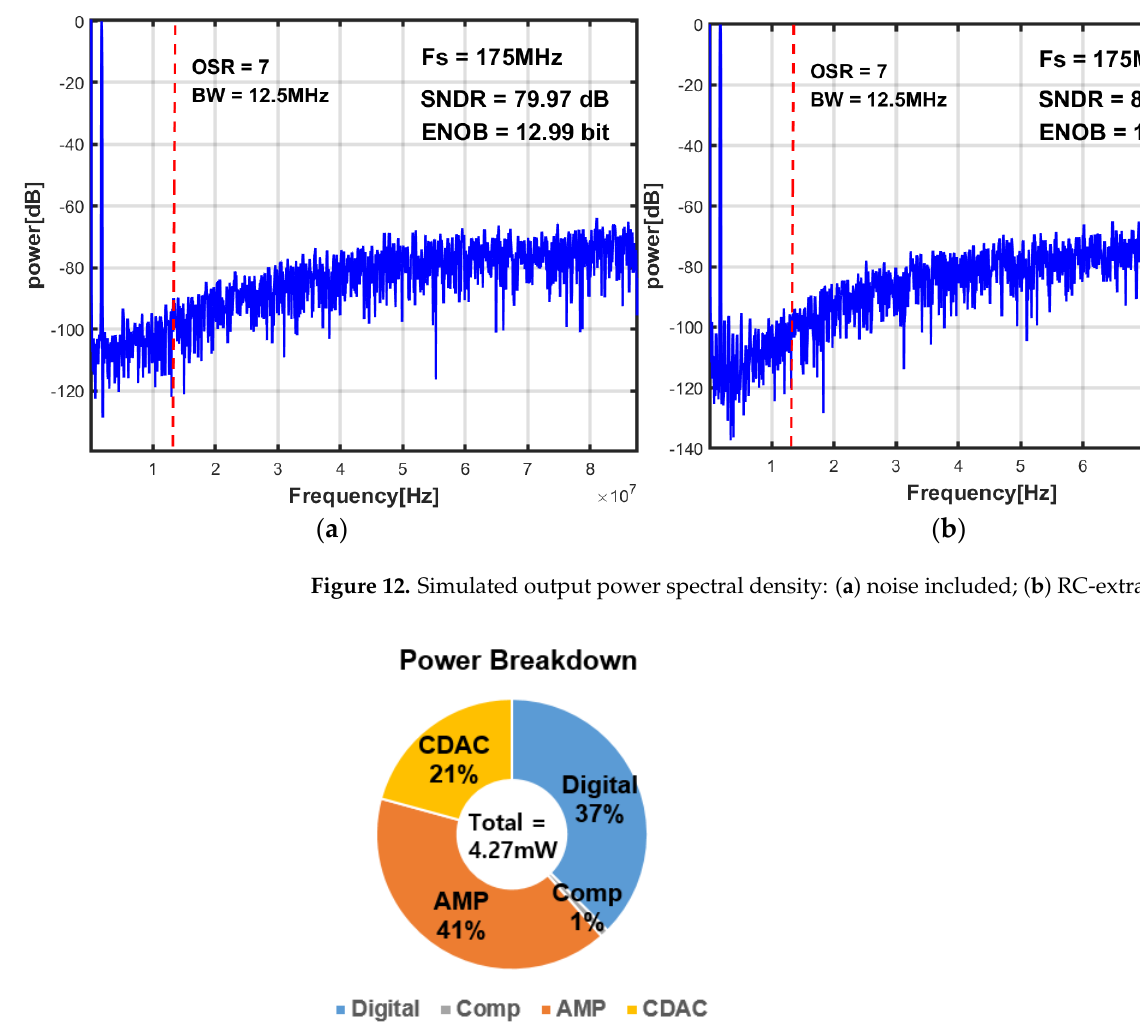
Figure 13. Power breakdown of proposed ADC. Table 1. Comparison